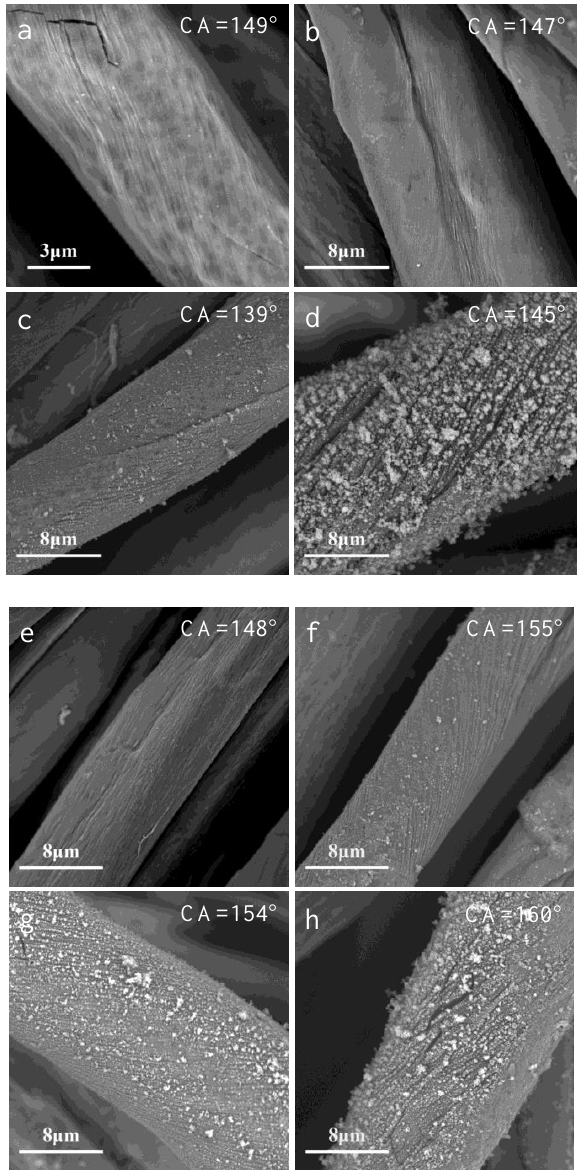
Figure 3. Scanning electron microscope (SEM) images and contact angle (CA) values of cotton fabric treated by different precursor value: N 2 plasma ( a ) 10 g/h, ( b ) 15 g/h, ( c ) 20 g/h, ( d ) 30 g/h; O 2 plasma